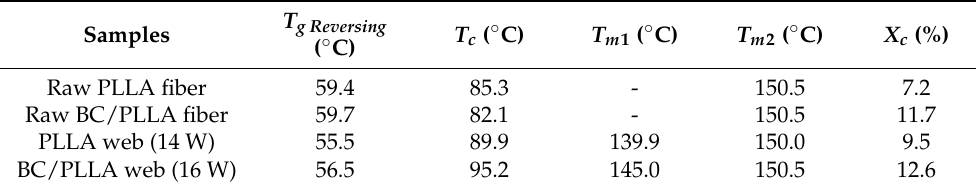
Figure 14. ( a ) Total heat flow curves, ( b ) reversing heat flow curves, and ( c ) non-reversing heat flow curves of raw PLLA and BC/PLLA fibers and electrospun PLLA (14 W) and BC/PLLA (16 W) webs determined by temperature-modulated differential scanning calorimetry (TMDSC). Table 1. Temperature-modulated differential scanning calorimetry results for raw poly-(L-lactide) (PLLA) and bamboo charcoal (BC)/PLLA fibers and electrospun PLLA (14 W) and BC/PLLA (16 W) webs.